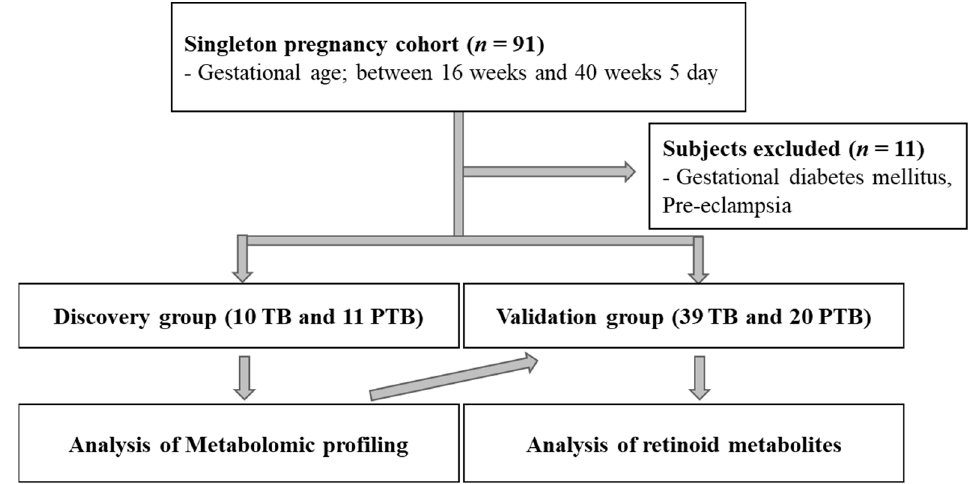
Figure 1. Flowchart for subject selection. TB, term birth; PTB, preterm birth. Table 1. Clinical characteristics of subjects for validation ( n = 59).